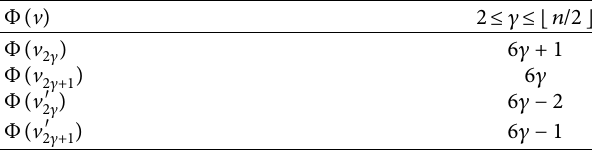
Table 32: Vertex labeling of Φ ( v ).